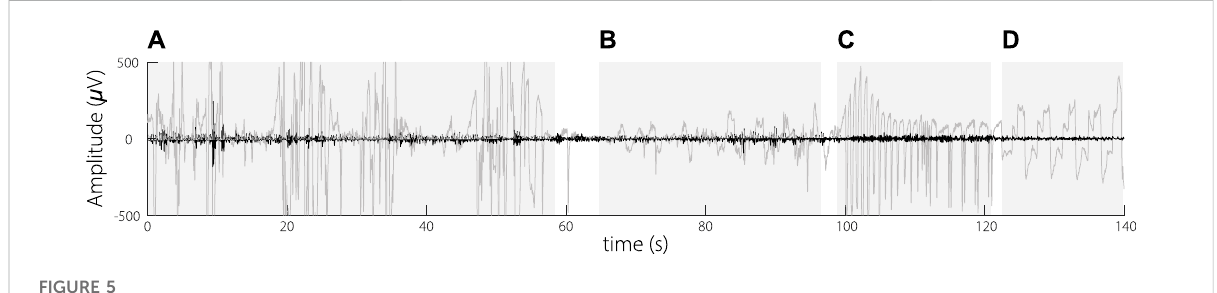
FIGURE 5 ASR applied on signal from Fp1 channel. Raw signal (grey) and enhanced signal (black). Artifacts (A) horizontal head motions; (B) vertical head motions; (C) Eye blinks; (D) Eye